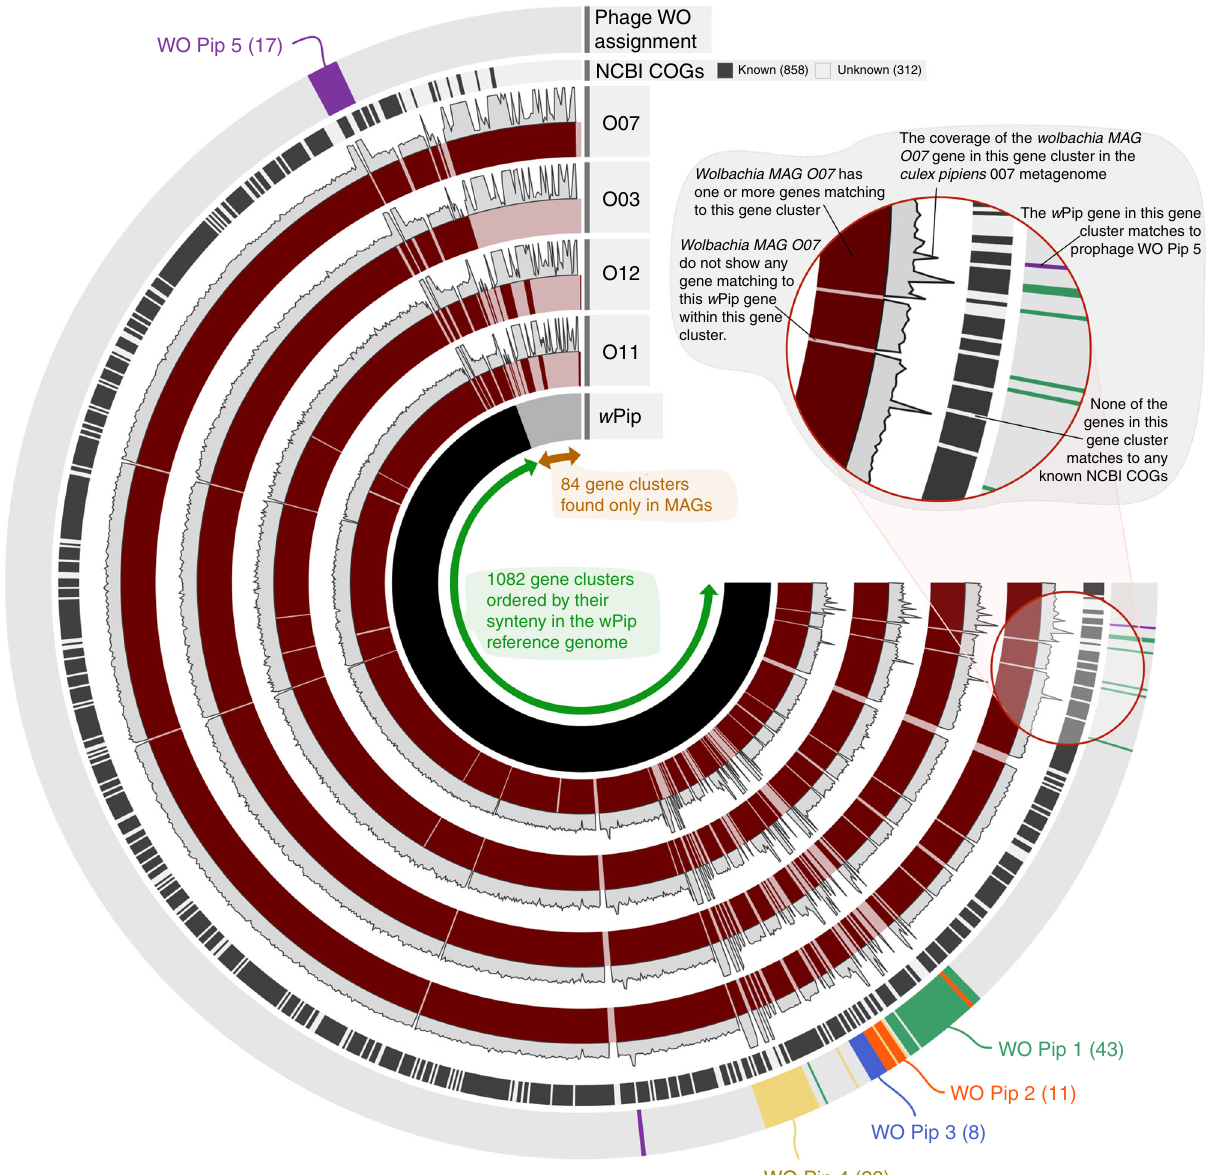
Fig. 4 Wolbachia metapangenome in the context of w Pip Pel genome synteny. The fi gure shows the presence – absence of 1166 gene clusters in the pangenome of four Wolbachia metagenome-assembled genomes (MAGs) and the reference genome w Pip Pel. The gene clusters (i.e., groups of homologous genes based on amino acid sequence identity) are organized based on w Pip Pel synteny. Each MAG is represented by two layers, where the fi rst layer indicates the presence or absence of a gene cluster in a given MAG, and the other shows the average coverage of each Wolbachia MAG O07 gene cluster in the corresponding C. pipiens metagenome. The second to last layer shows whether genes in a given gene cluster have a match in NCBI ’ s COGs. The outermost layer associates gene clusters with previously identi fi ed prophage regions in the w Pip Pel genome. The number of gene clusters assigned to WOPip prophage regions are indicated in